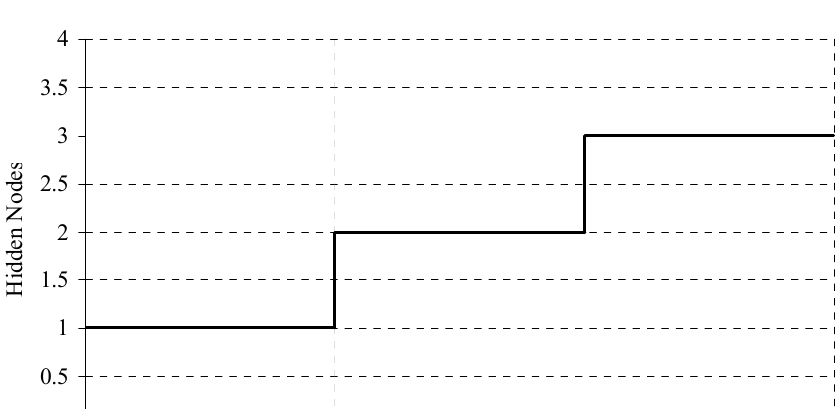
Figure 9. Hidden node addition for the diabetes